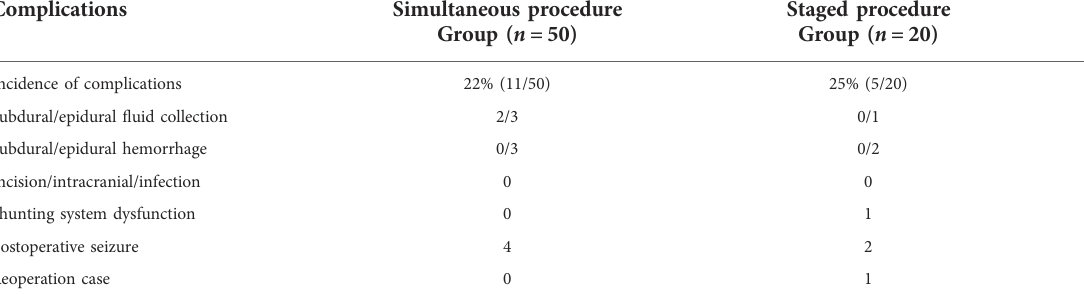
TABLE 2 Comparison of secondary complications between two